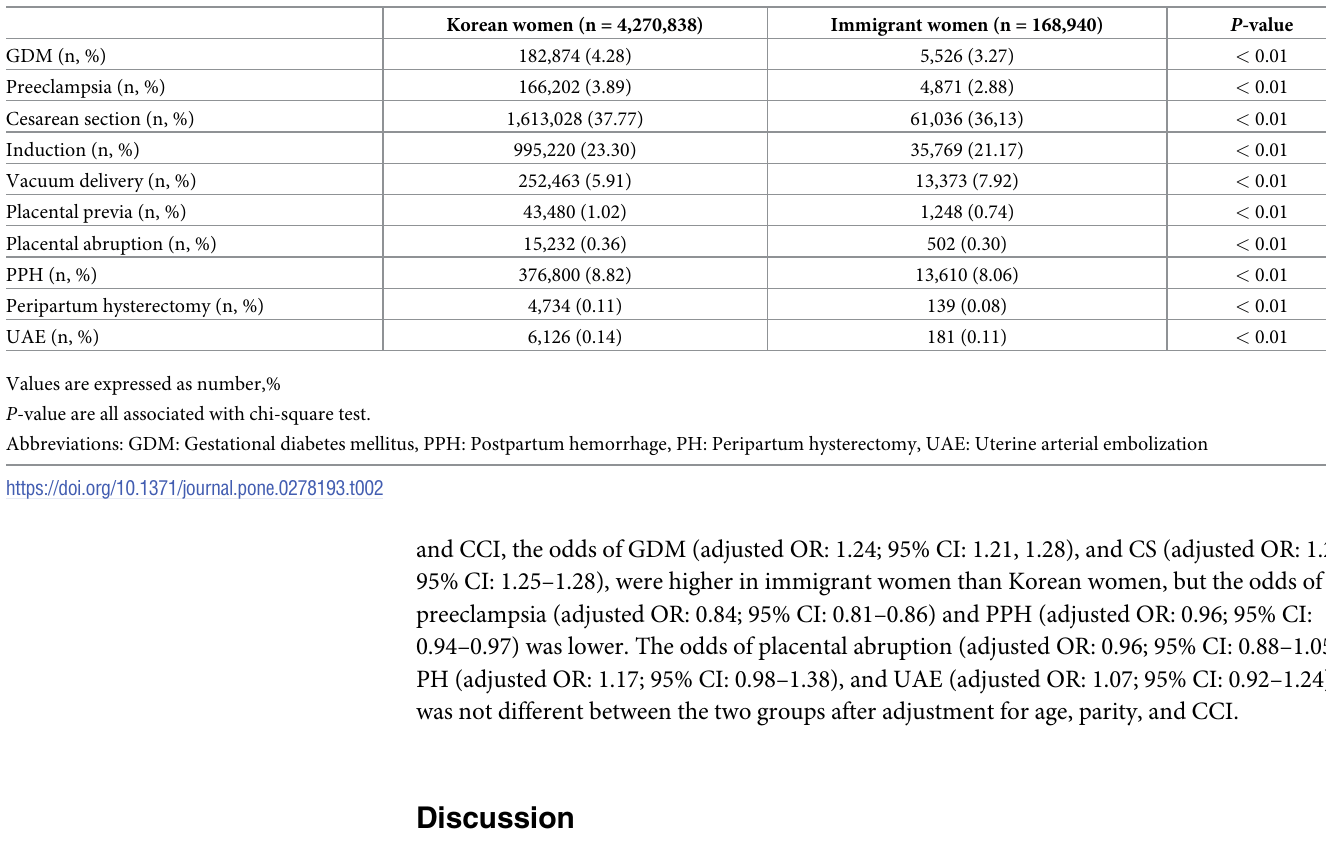
was not different between the two groups after adjustment for age, parity, and CCI.